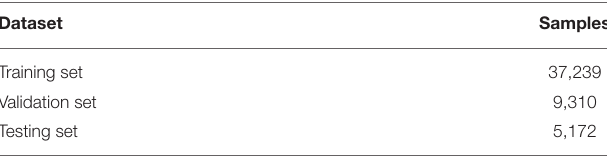
TABLE 3 | Dataset partition composition.